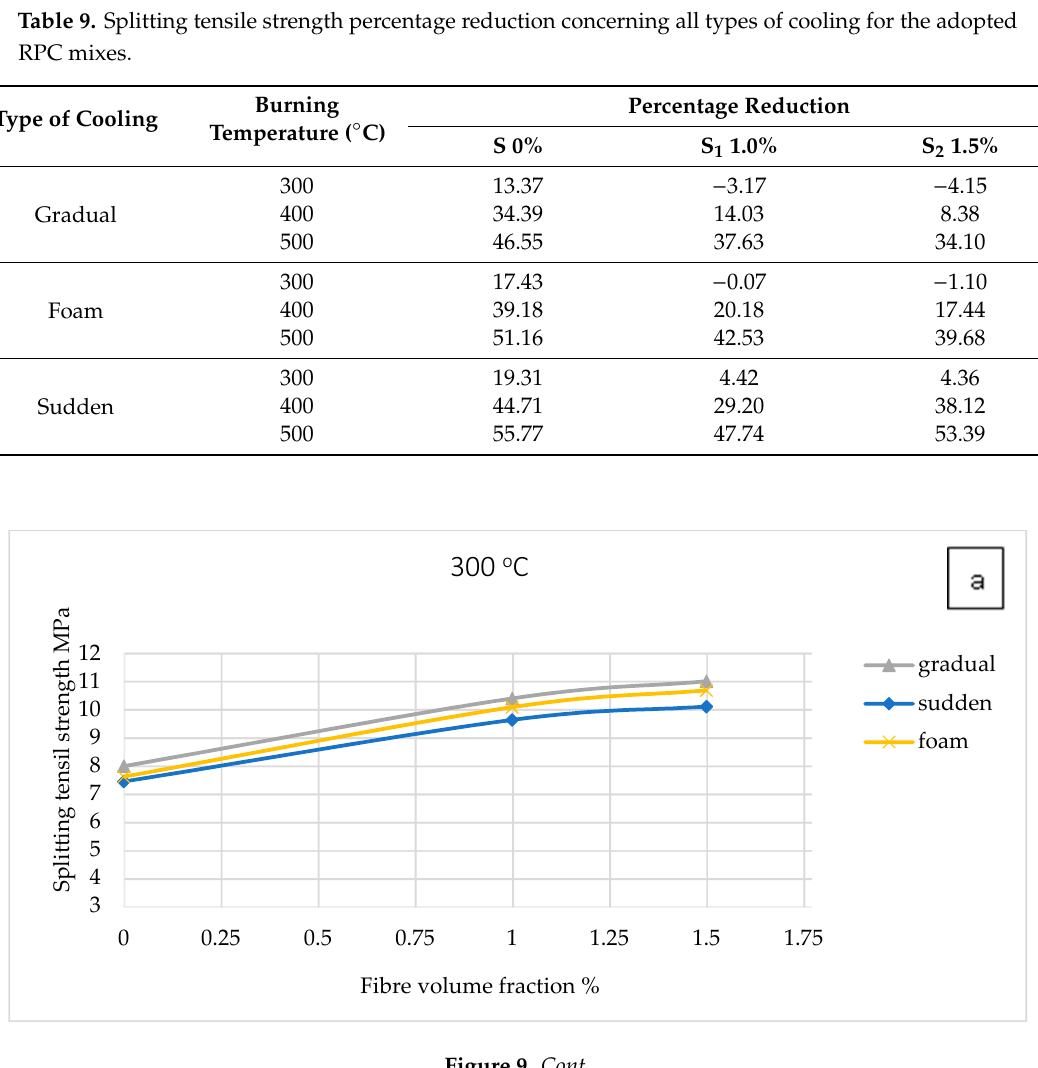
Table 9. Splitting tensile strength percentage reduction concerning all types of cooling for the adopted RPC mixes.